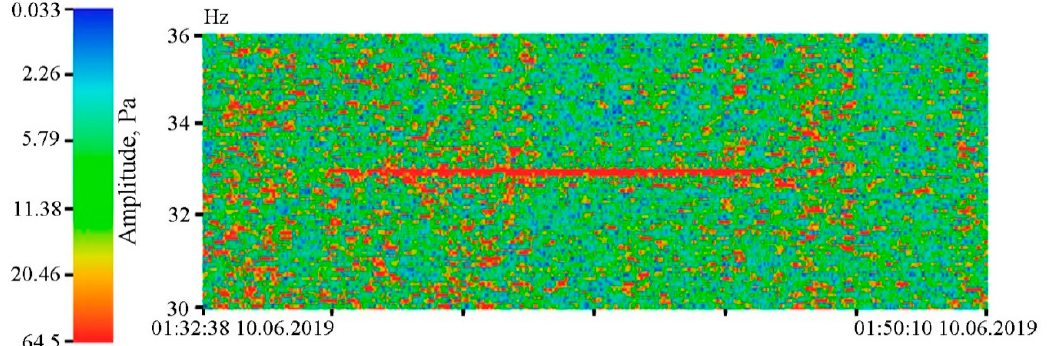
Figure 16. Dynamic spectrogram of the fragment of the supersensitive detector of hydrosphere pressure variations record, when a low-frequency hydroacoustic emitter is operating at the frequency of 33 Hz.